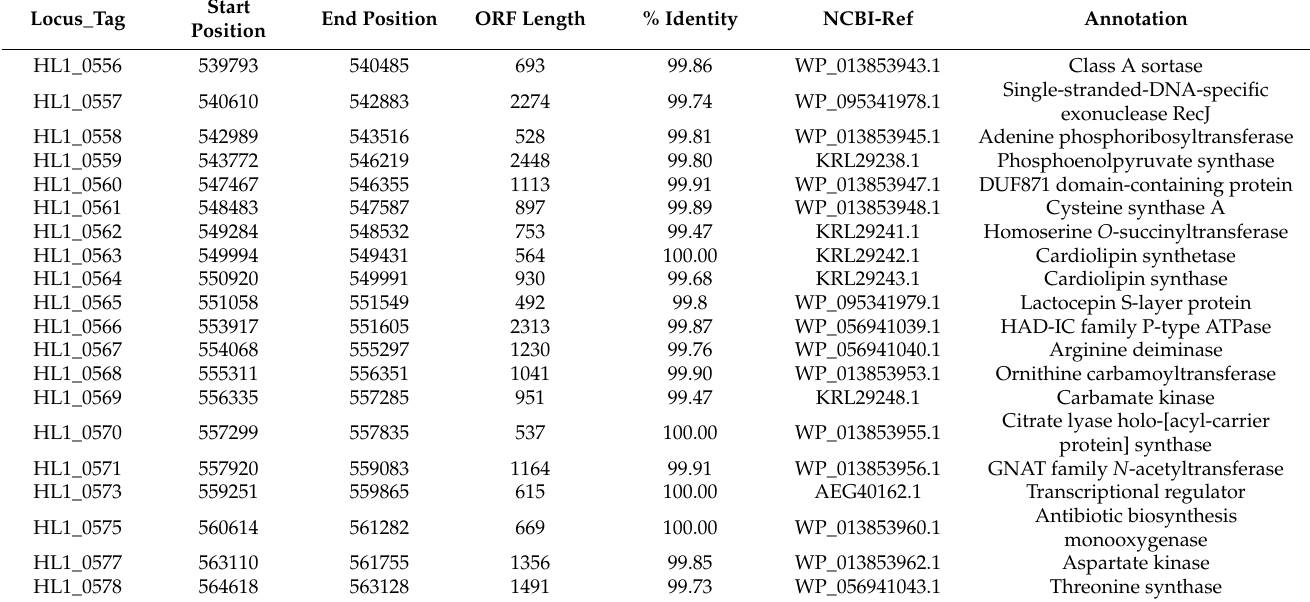
Table 5. Unique genes in L. kefiranofaciens strain HL1, as compared with